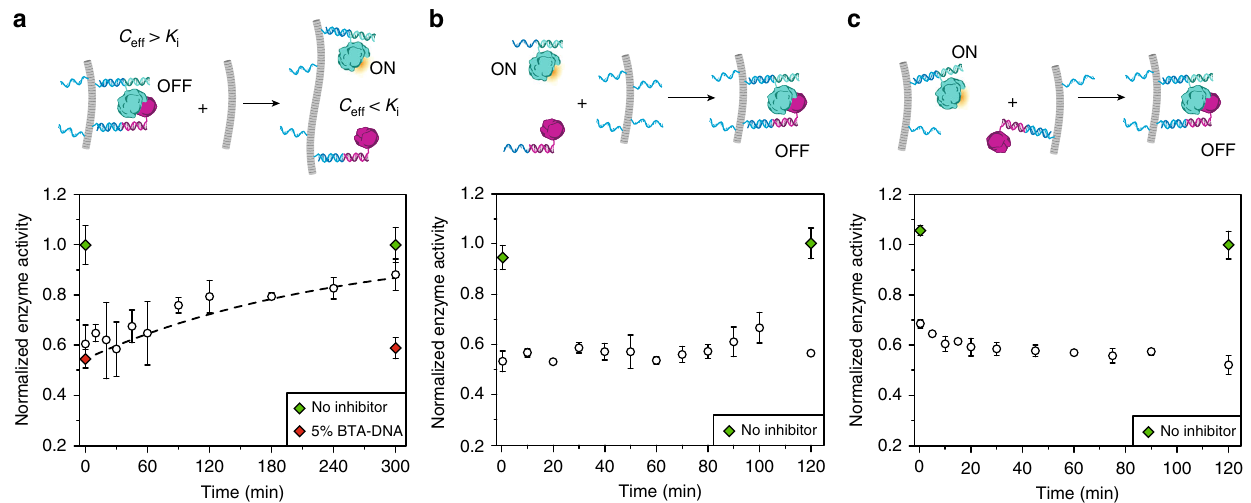
Fig. 4 Characterization of the dynamics of enzyme-inhibitor recruitment on the supramolecular polymer. a Enzyme activity as a function of time after the addition of pre-assembled polymers containing 100% BTA-3OH (9.5 μ L, 1 mM) to polymers composed of 5% BTA-DNA (0.5 μ M BTA-DNA, 9.5 μ M BTA- 3OH), 20 nM R E and R I , 1 nM β -lactamase and 10 nM BLIP (total volume = 40.5 μ L), yielding a fi nal BTA-DNA fraction of 0.25% (0.5 μ M BTA-DNA, 199.5 μ M BTA-3OH, fi nal total volume = 50 μ L). The dashed line represents the fi tting of a single exponential with fi xed values at t = 0 of the activity in the 5% BTA-DNA reference sample and at t = ∞ of the activity in the reference sample omitting BLIP yielding t 1/2 = ~3 h. The green diamonds represent the activity of a sample without inhibitor. The red diamonds represent the activity of the system containing 5% BTA-DNA, which was not diluted by addition of 100% BTA-3OH. b Kinetics of enzyme-inhibitor complex formation upon recruitment to the DNA-decorated polymers. Enzyme activity was measured at different time-point after adding the BTA polymers to a mixture of β -lactamase, BLIP R E and R I . Experiments were performed using 25% BTA-DNA (0.5 μ M BTA-DNA, 1.5 μ M BTA-3OH), 20 nM R E and R I , 1 nM β -lactamase and 10 nM BLIP. c Enzyme activity as a function of time after mixing pre-assembled polymers containing either enzyme and R E or inhibitor and R I . Experiments were performed using fi nal concentrations of 25% BTA-DNA (0.5 μ M BTA- DNA, 1.5 μ M BTA-3OH), 20 nM R E and R I , 1 nM β -lactamase and 10 nM BLIP. Enzyme activities were normalized to a control omitting the inhibitor protein (green diamonds). Error bars represent the s.d. calculated from triplicate